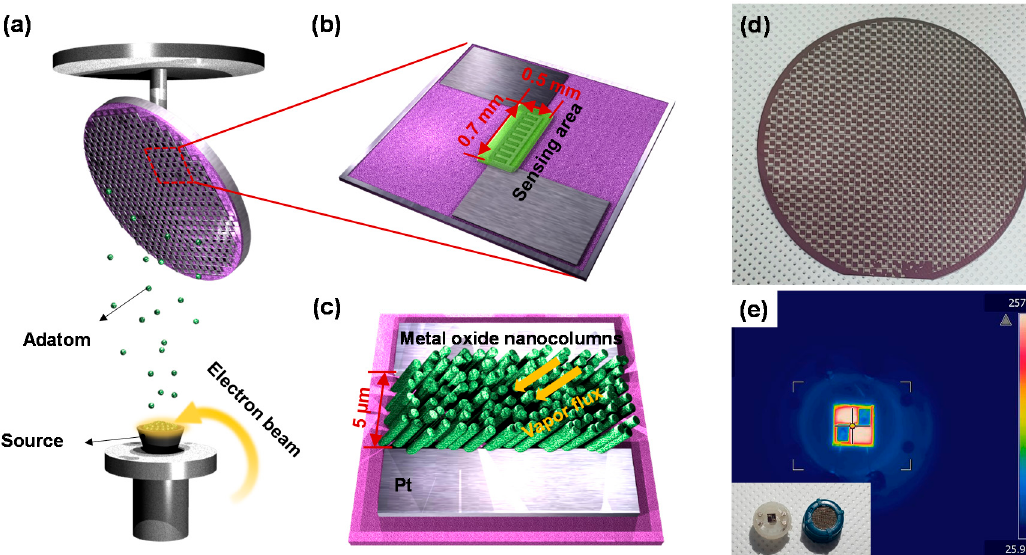
Figure 1. Schematics of ( a ) the wafer-scale fabrication procedure for highly sensitive gas sensors based on metal-oxide NCs; ( b ) a design of Pt IDEs with sensing area; and ( c ) metal-oxide NCs grown I the direction of the vapor flux; ( d ) Photograph of 4 in wafer fully covered with Pt-IDEs patterns; ( e ) Thermographic images showing temperature variation in the Pt-IDEs-patterned substrate at 4 V. Inset shows photograph of our sensor on micro-heater and its cap.